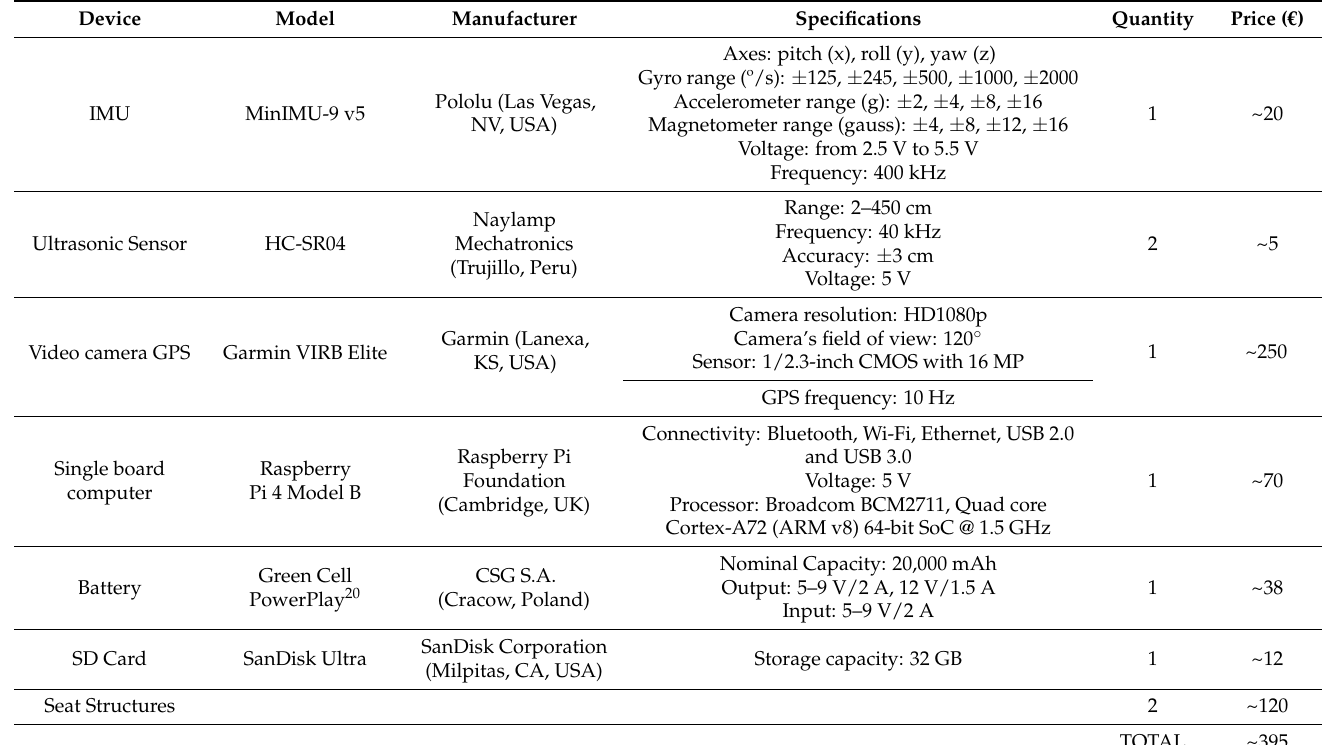
Table 1. Summary of